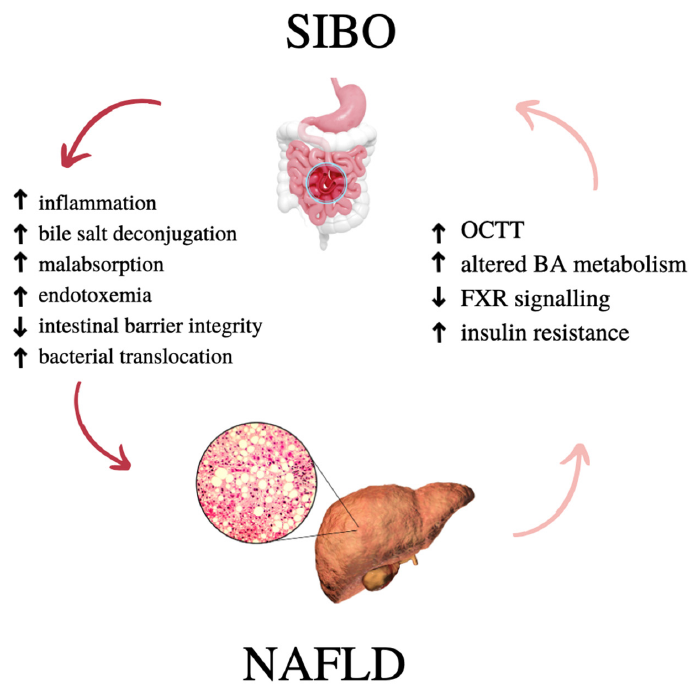
Figure 1. Possible SIBO and NAFLD interactions. OCTT—oro-ceacal transit time; BA—bile acids; FXR—farnesoid X receptor. FXR—farnesoid X